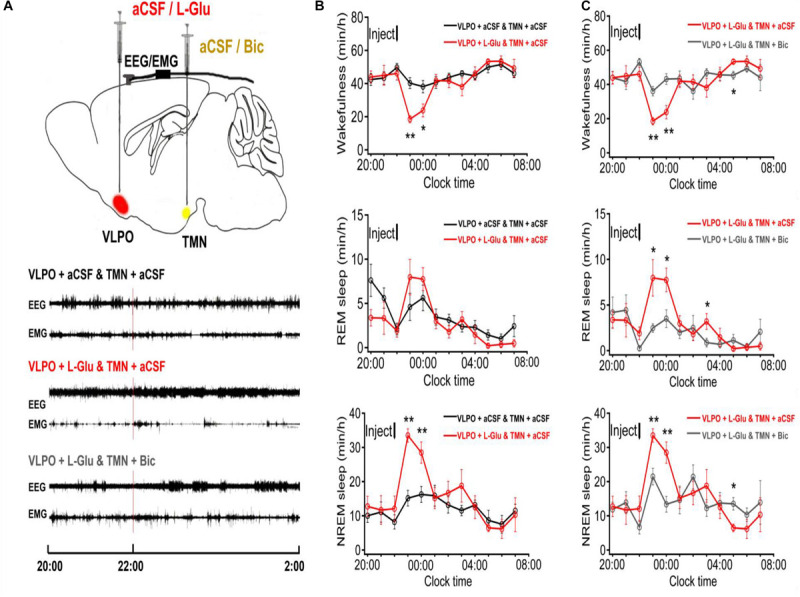
The sleep-wakefulness cycle was influenced by injecting L-Glu into VLPO which could be blocked by injecting Bic into TMN. (A) Top: Schematic drawing of the location of drug injection, or aCSF into the VLPO/TMN of a rat (Red: aCSF/L-Glu into VLPO, Yellow: aCSF/Bic into TMN). Bottom: Representative traces of EEG and EMG with drug injected. Drugs were applied at 22:00 (red line), and PSG recording started from 20:00 and lasted for 24 h. (B) Time-course changes of the sleep-wakefulness cycle in rat administration with L-Glu into VLPO. (C) Time-course changes of the sleep-wakefulness cycle in rat administration with L-Glu into VLPO and Bic into TMN. Data were presented as mean ± SEM. The paired t-test was used in the statistical comparisons of two groups. *p < 0.05, **p < 0.01 is compared between two groups at the same time. The arrow shows the time of microinjection.